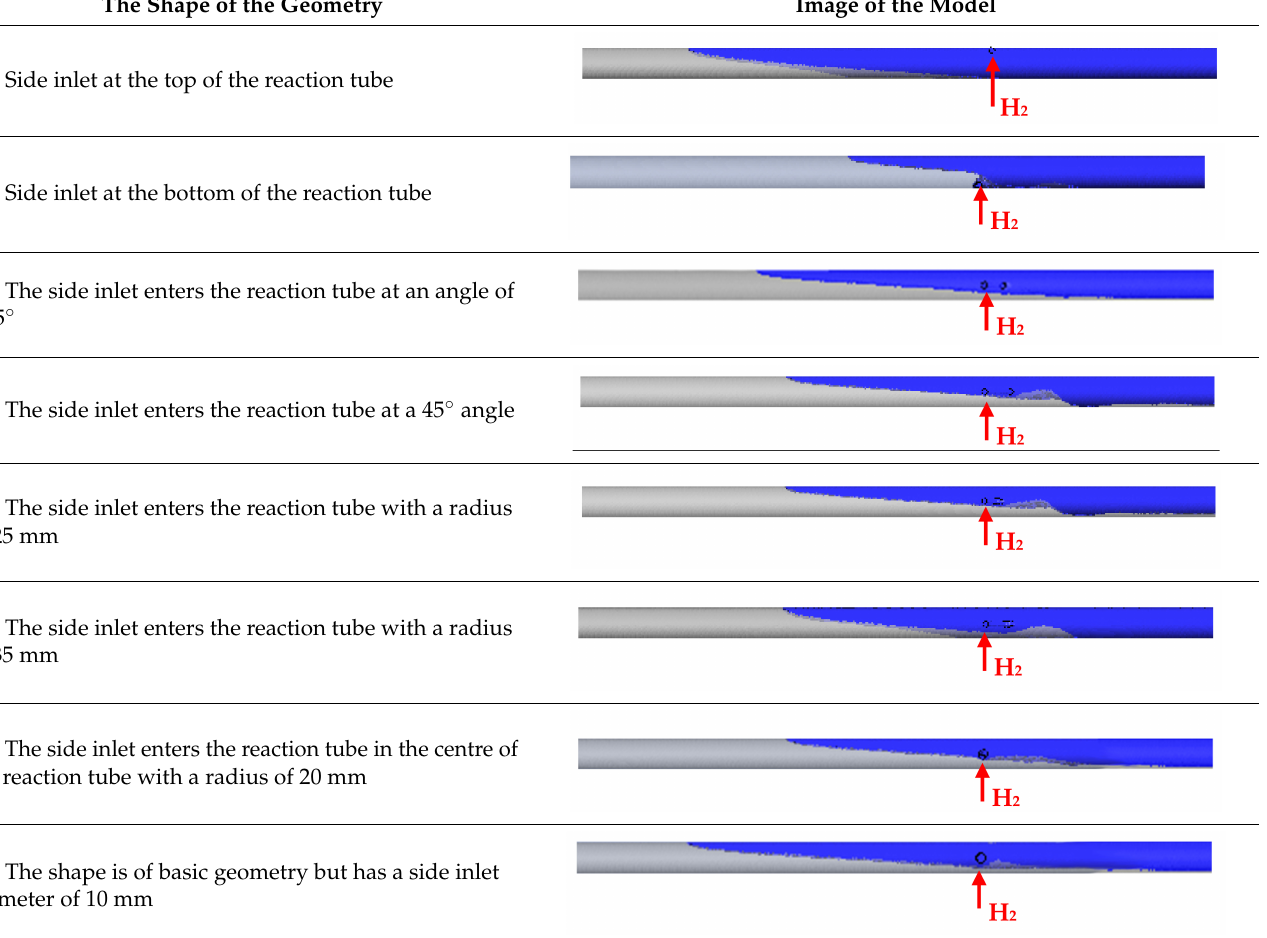
Table 5. Simulation results of different geometries (blue—H 2 profile, grey—N 2 profile). The Shape of the Geometry Image of the